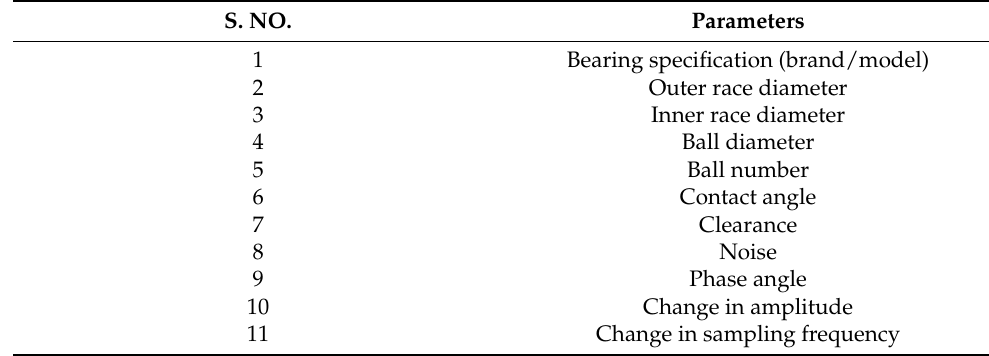
Table 2. Parameters that effect the signals of